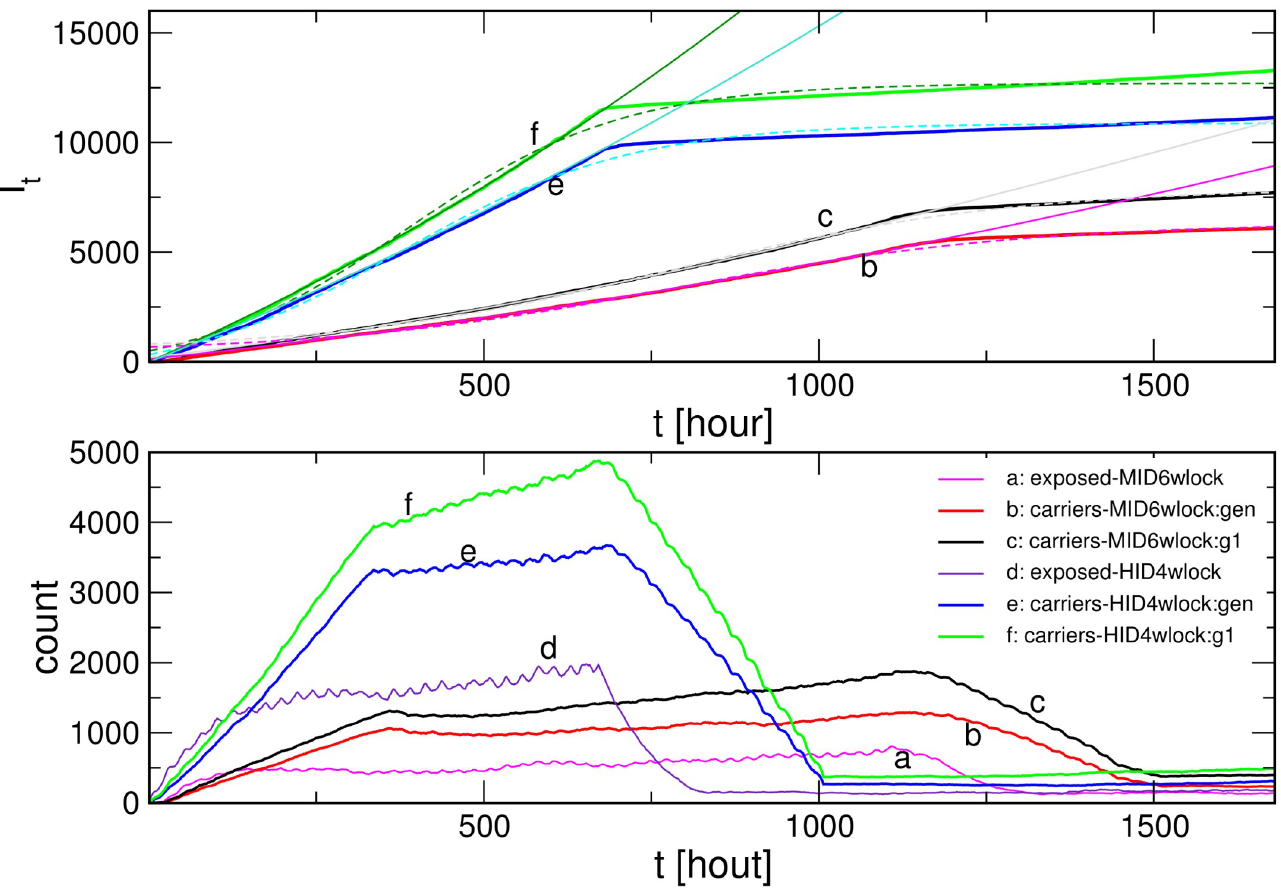
Fig 6. Impact of the social dynamics preceding a lockdown. Top: Infection curves for high-intensity dynamics and lockdown after week 4, and low-intensity dynamics with the lockdown after week 6; two lines in each case are the scenarios with/without virus mutations. Fits according to the logistic function (see text). Bottom: Temporal fluctuations of the number of exposed agents and the number of carriers and the number of active virus spots corresponding to the infection curves in the top panel.